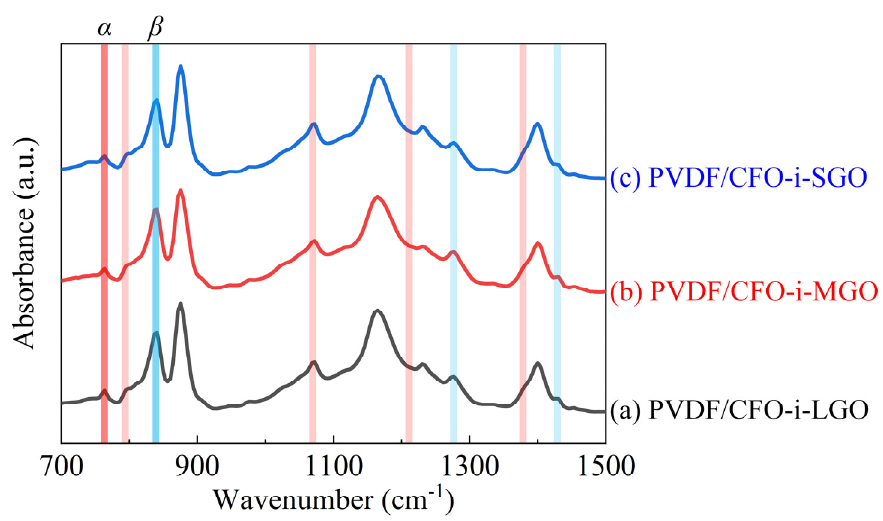
Figure 8. Fourier-transform infrared (FT-IR) spectra of the 3-2 type ME films of ( a ) PVDF/CFO-i- LGO, ( b ) PVDF/CFO-i-MGO, and ( c ) PVDF/CFO-i-SGO. ( b ) PVDF/CFO-i-MGO, and ( c ) PVDF/CFO-i-SGO.